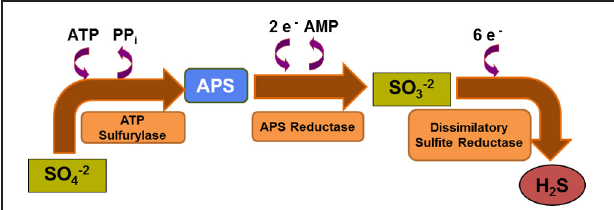
FIGURE 2 | Dissimilatory sulfate reduction pathway. Microbial sulfate reduction relies on sequential catalytic reactions in which reduction of sulfate is coupled with oxidation of H 2 or simple organic molecules. This anaerobic respiration pathway is less favorable thermodynamically than aerobic